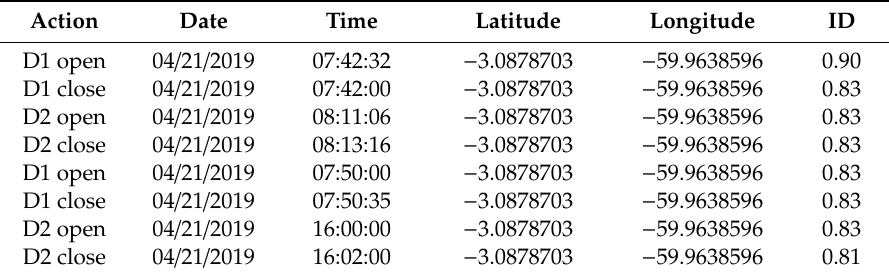
Table 2. Dataset sample from closing and opening the doors.